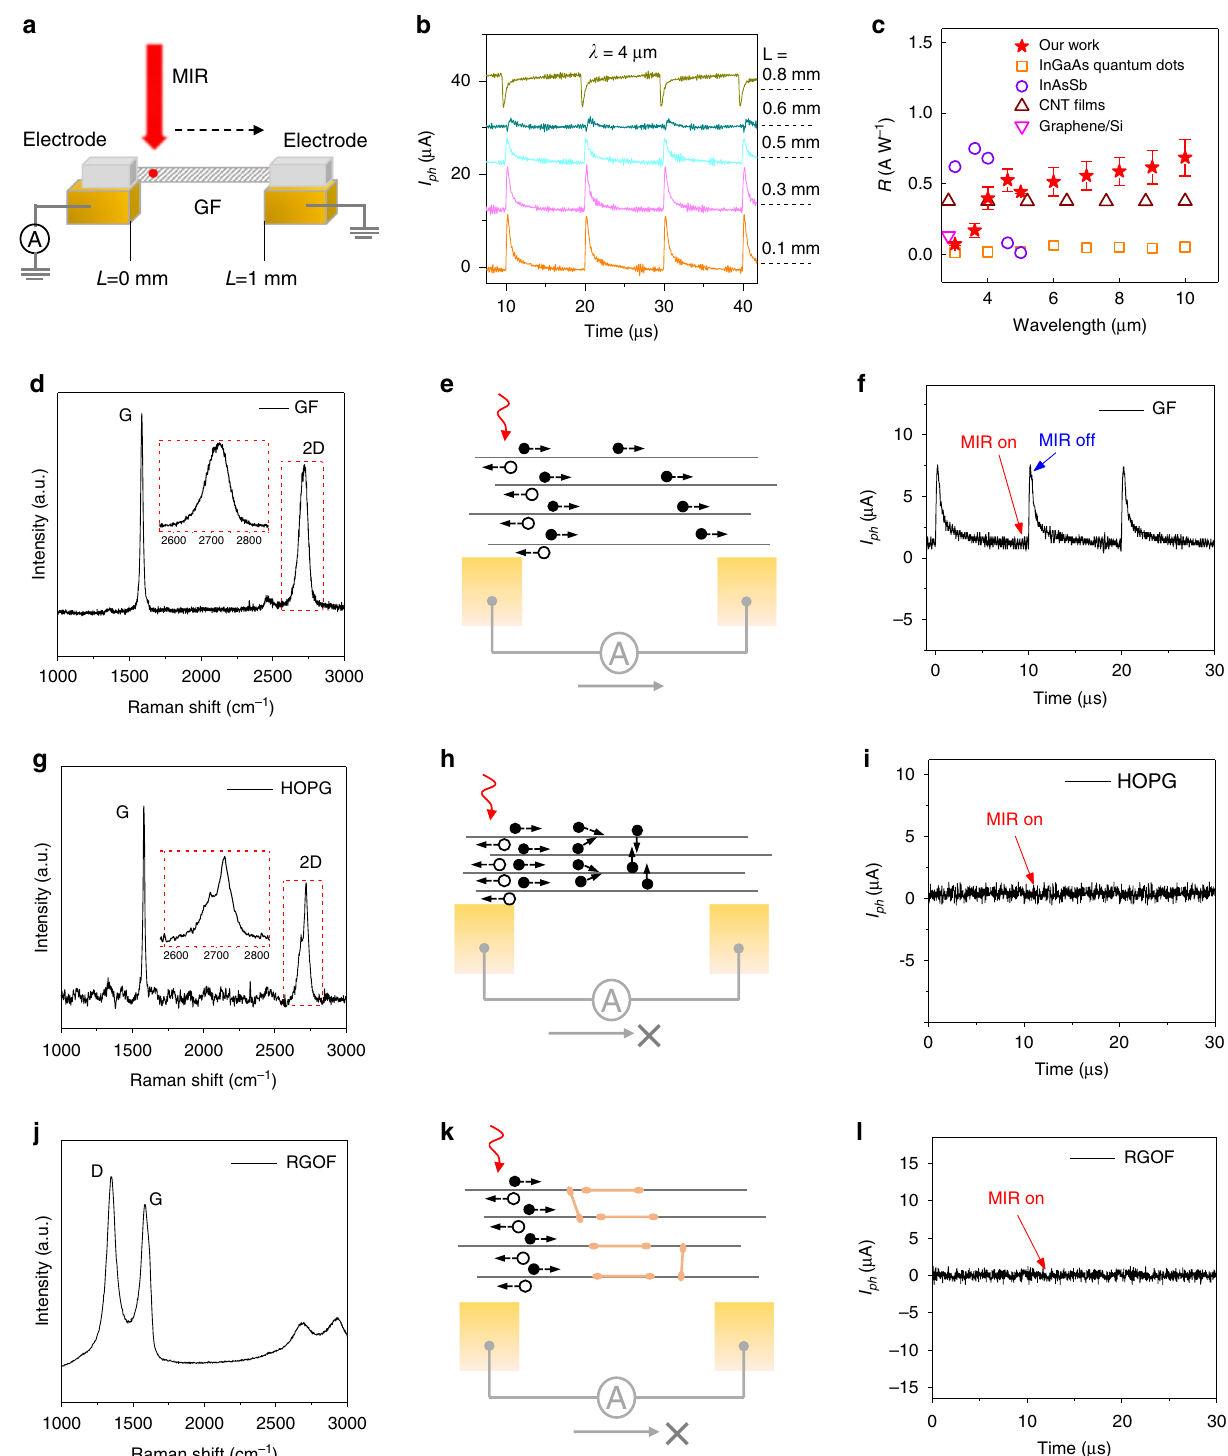
Fig. 2 GF operation in MIR detection mode. a Schematic of 1 mm long GF suspended between gold electrodes illuminated by 4 μ m wavelength femtosecond laser ( fl uence = 4.9 W cm − 2 ) at constant voltage bias of 3 mV. b Photoresponse of GF when the laser spot moved from one electrode to the other. The position of the laser spot along the GF length is labeled next to the response signal. Photoresponse curves are shifted for clarity. c A comparison of responsivities of state-of-the-art MIR photodetectors with GF. Raman spectra, the corresponding MIR response, and the simpli fi ed schematics of presumed photo-carrier transport mechanisms of GF ( d – f ), highly oriented pyrolytic graphite (HOPG, g – i ) and reduced graphene oxide fi ber (RGOF, j – l ), respectively. The solid circles in e , h , and k represent electrons, and the hollow circles represent the hole. The orange lines in k represent sp 3 -hybridized topologic